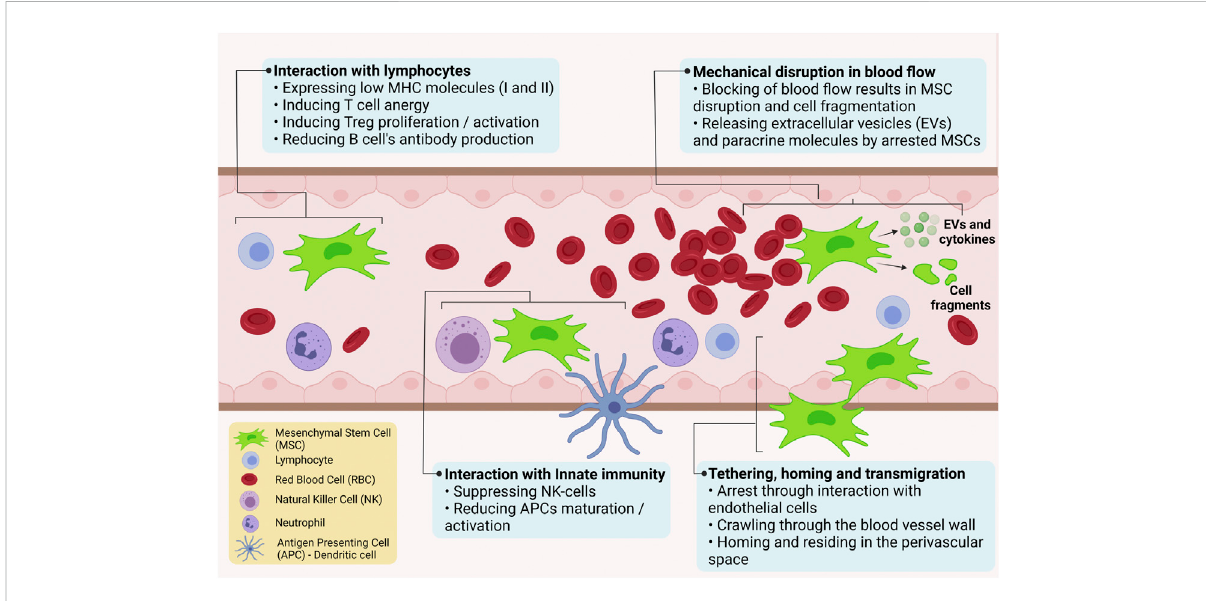
FIGURE 3 Schematic illustration of possible interactions of UC-MSCs following their systemic